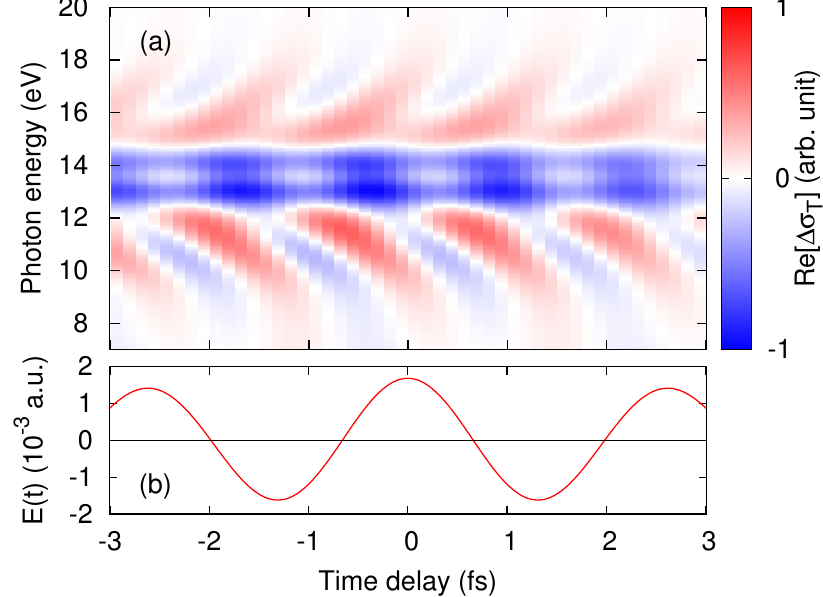
Figure 5. ( a ) transient surface conductivities of the combined two-band models at M and Γ points. This result is nothing but the summation of Figure 4a,b; ( b ) the time-profile of the applied pump electric